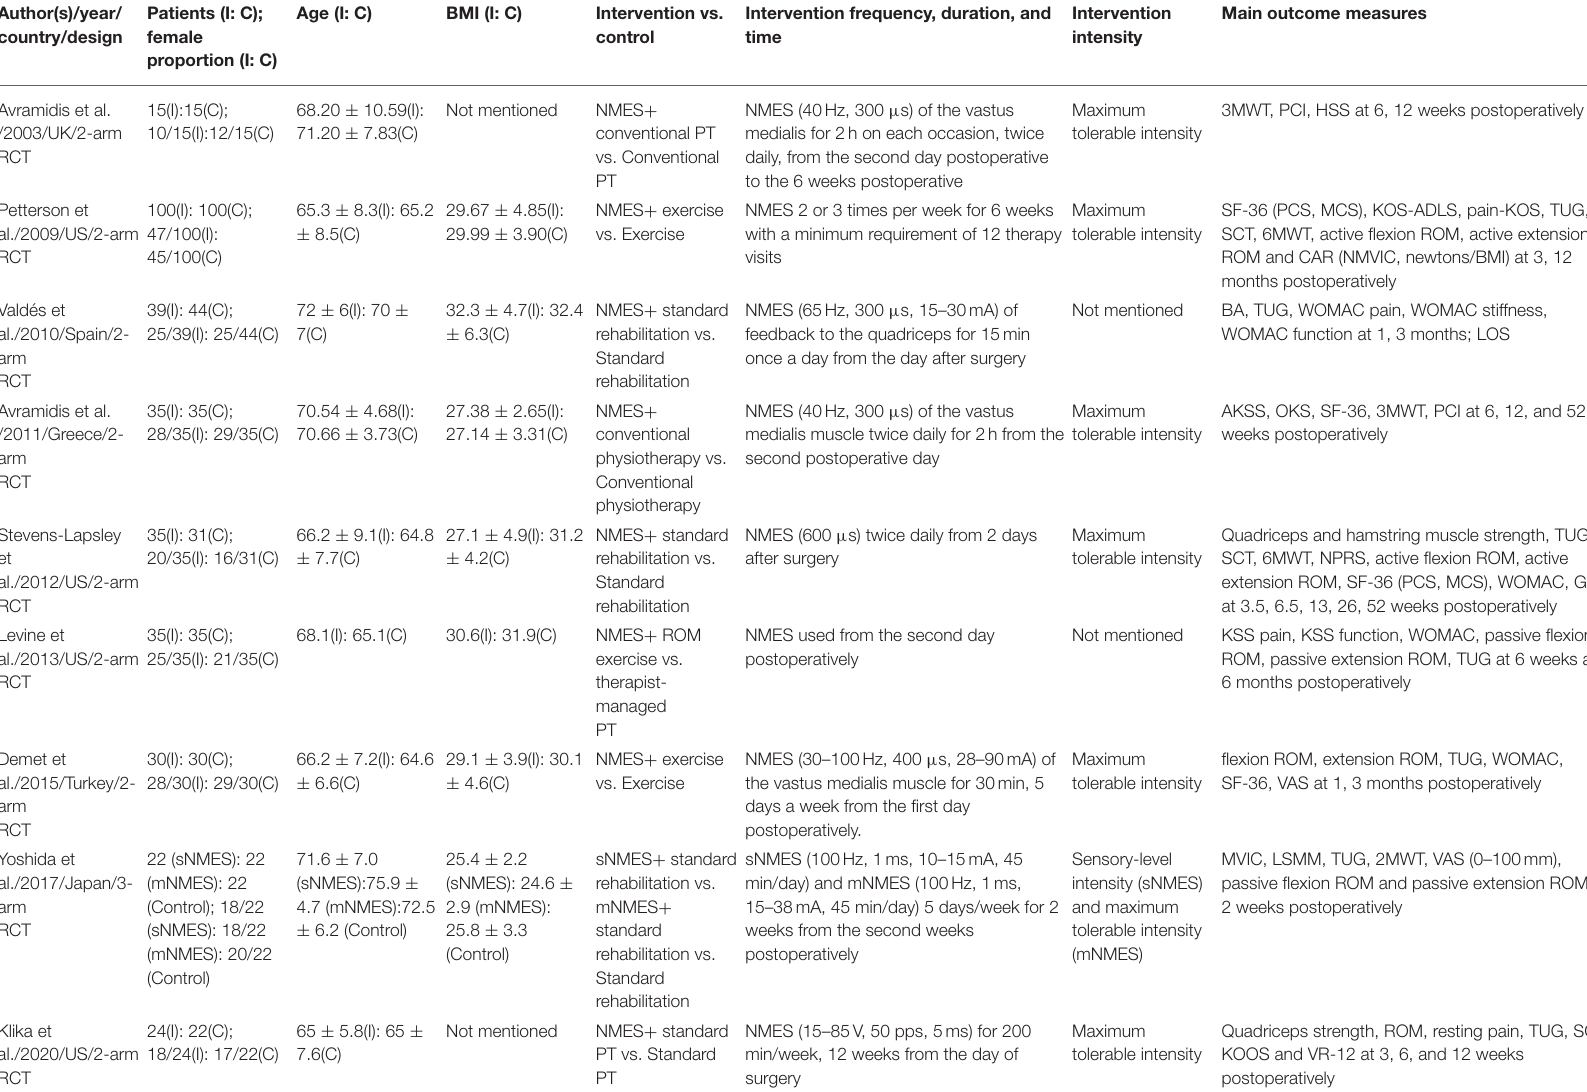
TABLE 1 | Characteristics of studies included in the meta-analysis. Author(s)/year/ Patients (I: C); country/design